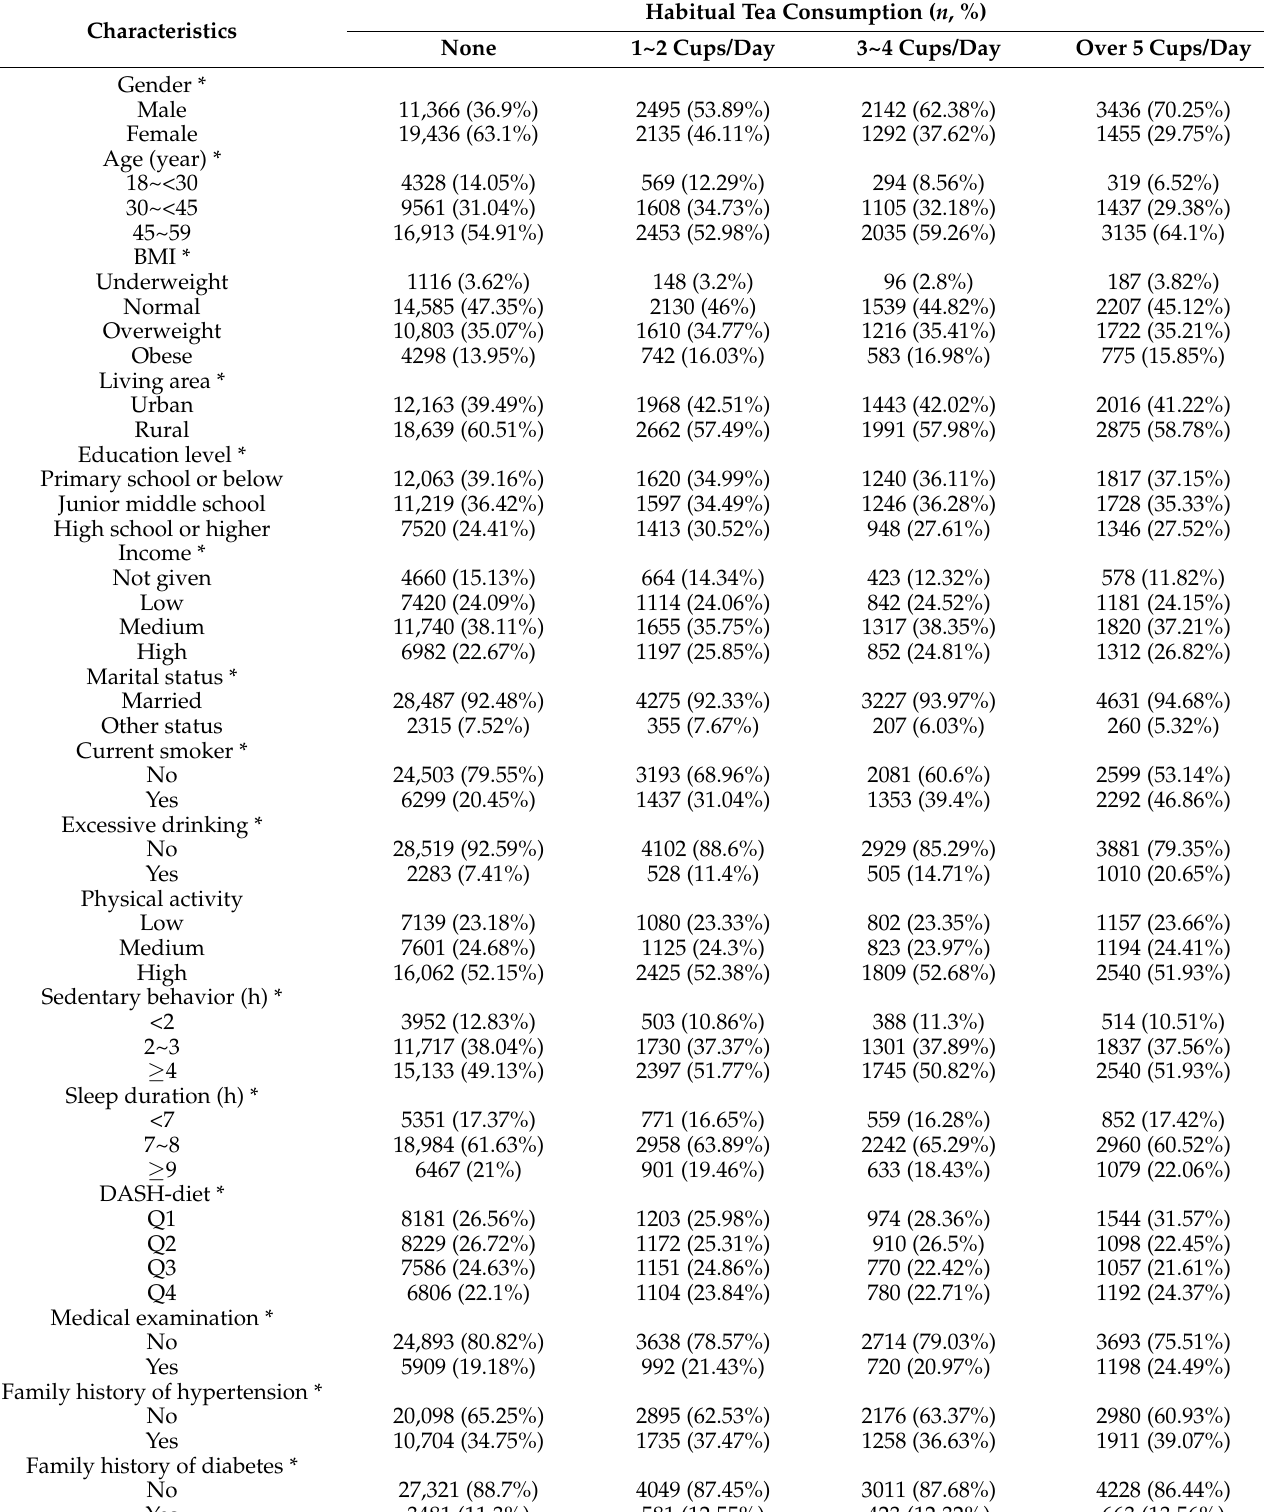
Table 2. Basic characteristics of participants aged 18~59 years in CNHS